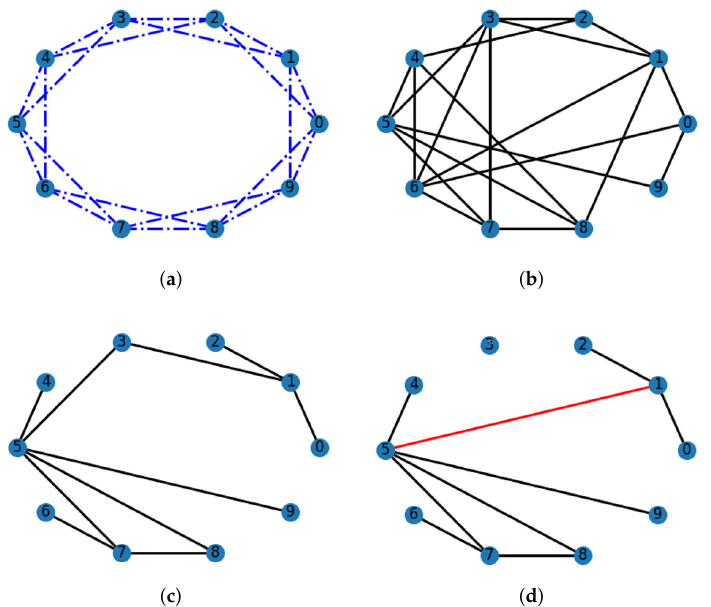
Figure 2. Entanglement percolation of a 10-node WS small-world quantum network. ( a ): A nearest- neighbor coupled network with four qubits per node, which are entangled with the qubits on the four neighbor nodes. Each edge in the network is a pure partially entangled state. ( b ): A WS small-world quantum network is established and a disconnect–reconnect operation is performed with probability p r = 0.6. ( c ): The partially entangled states that form the connected edges in the WS small-world quantum network are converted to the maximally entangled states by LOCC with probability p r = 0.6, and all the connected edges in the obtained network are maximally entangled state [6]. ( d ): An entanglement swapping is performed to disconnect the connected edges ( 3,5 ) ( 1,3 ) and connect ( 1,5 ) . A communication link is established between nodes 1 and 5 (red